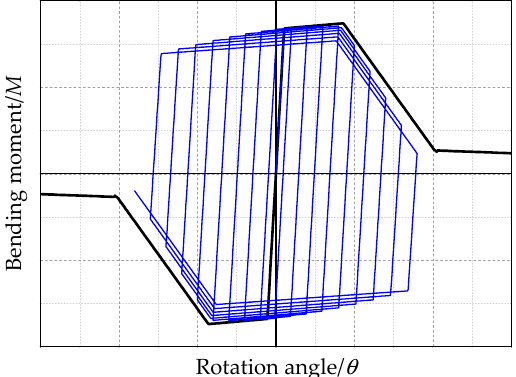
Figure 5. Hysteretic curve of the double-line IMK model.